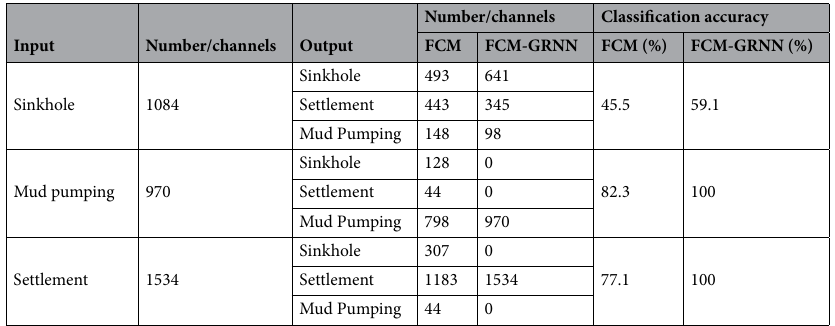
Table 1. The accuracy recognition of railway subgrade defects.